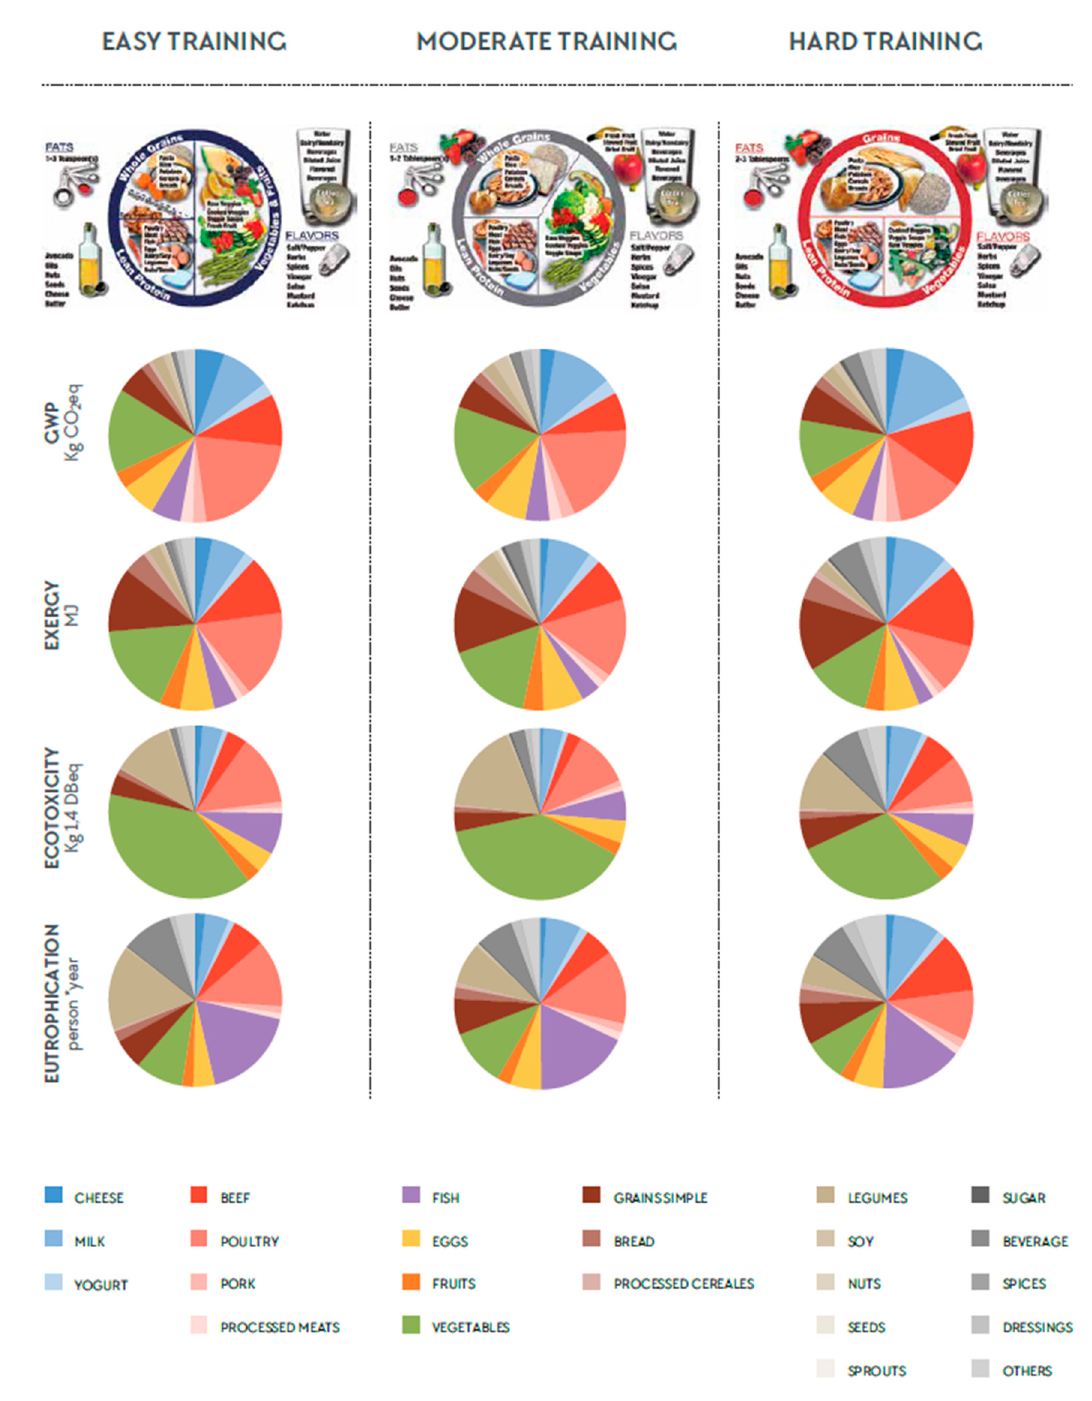
Figure A1. The contribution of each food group by training load and environmental impact category per plate.